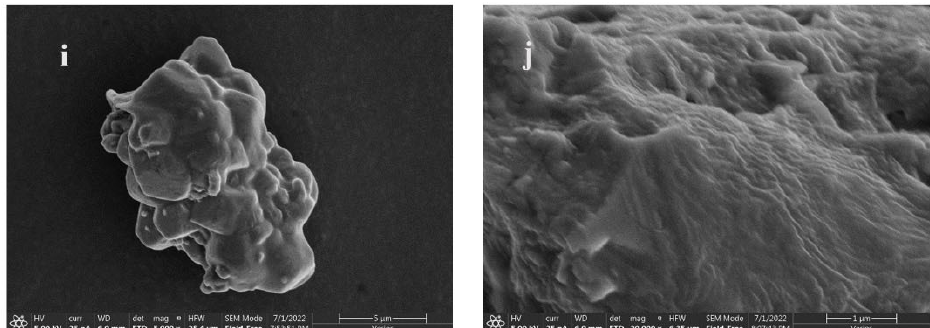
Figure 6. SEM microstructures of milk tea with different stabilizers. ( a , b ): Blank group; ( c , d ): Arabic gum group; ( e , f ): β -CD group; ( g , h ): Agar group; ( i , j ): Compound group.